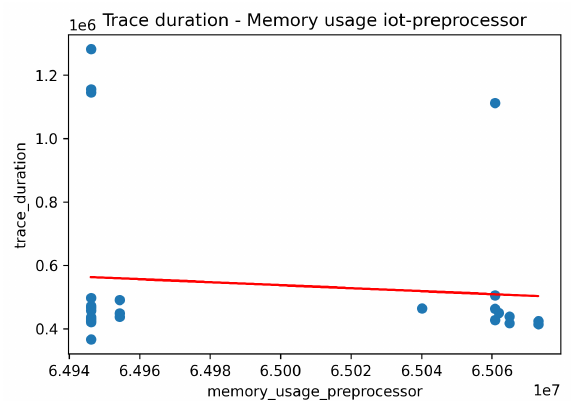
Figure 17. Correlation between trace duration and memory usage—IoT Preprocessor